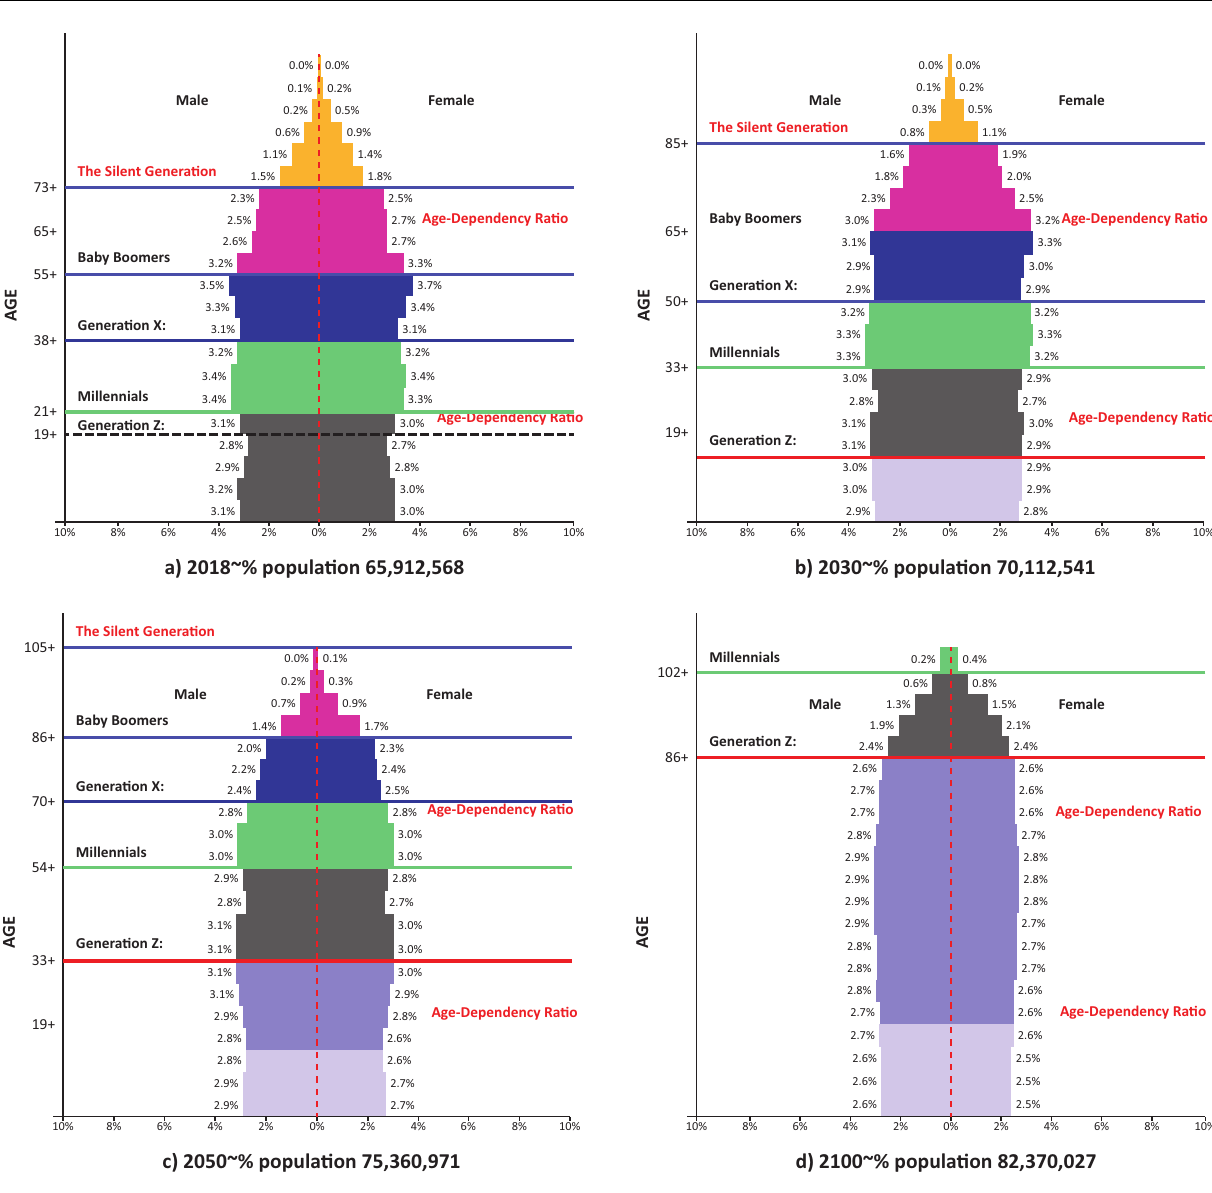
Figure 1. Population pyramids for the 5 generational birth-cohort (the Silent Generation, Baby Boomers, Generation X, Mil- lennials and Generation Z) in England and Wales. Notes: The Y axis shows variation of age range for each generation cohort for the target years changes in population structure; age groups based on age distributions of United Nations